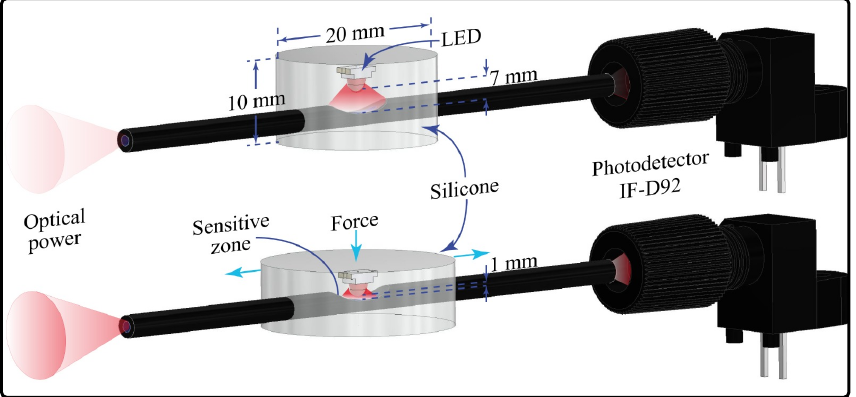
Figure 5. Working principle of contact force sensor.